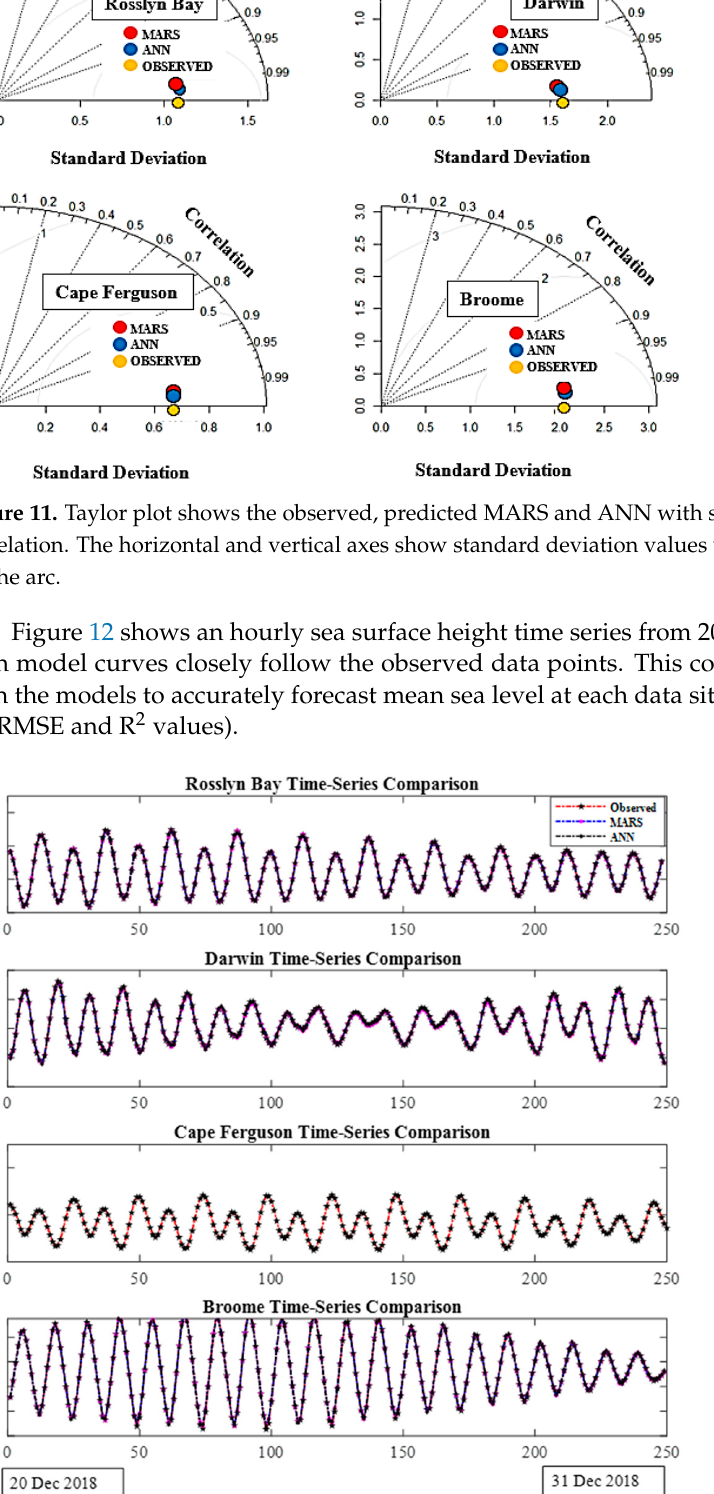
Figure 13. Cyclone track locations have been shown in red line for severe tropical cyclone Marcia (15 February–1 March 2015) and blue line for severe tropical cyclone Narelle (5–15 January 2013). The locations of tide gauges used for this study are shown in red squares.